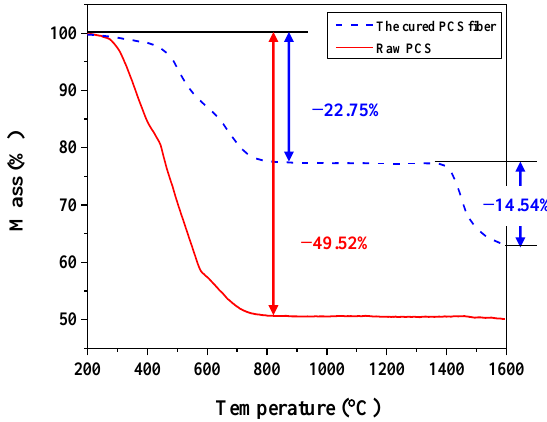
Figure 2. TG curves of raw PCS and iodine-cured PCS fibers.